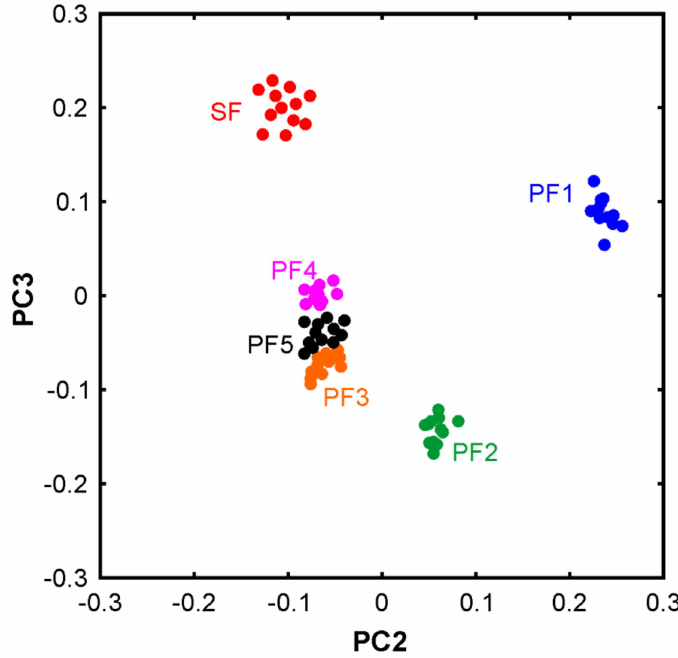
Figure 2. Principal component analysis of the six pure oil samples. Variance covered: PC1 (99.9208%), PC2 (0.0270%), and PC3